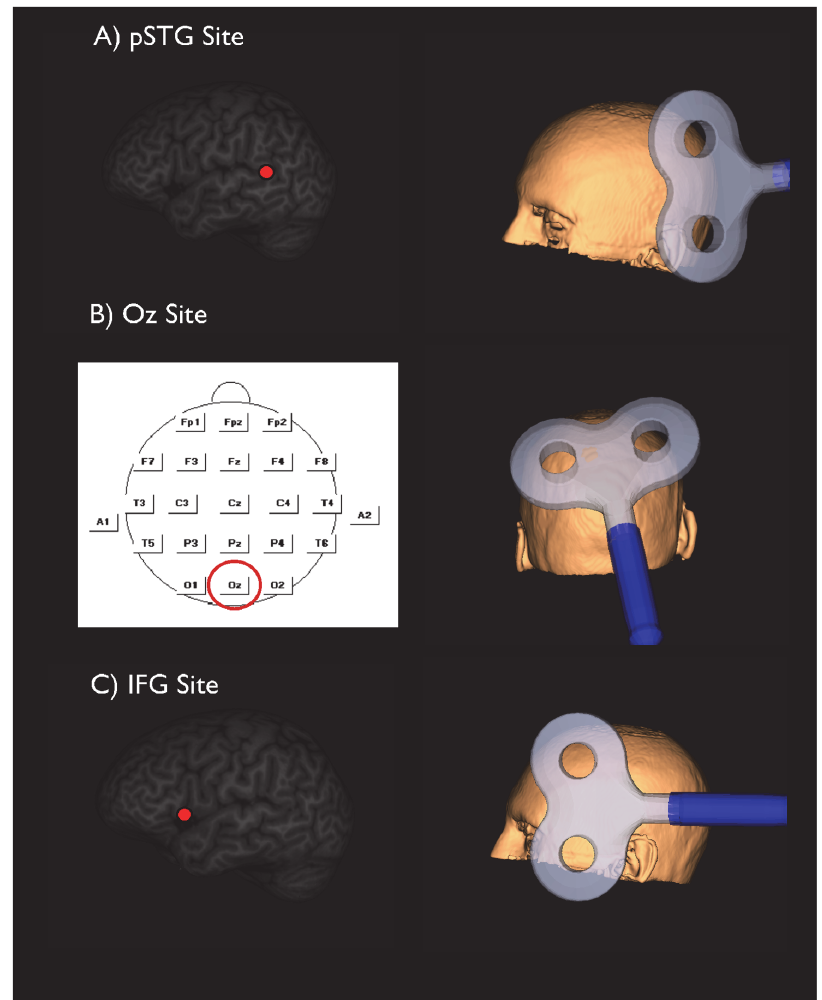
Fig 2. The mean location of the target and orientation of the stimulator during rTMS of: (A) caudalmost portion of the temporal gyrus, pSTG; (B) control site, Oz; and (C) inferior frontal gyrus, IFG.